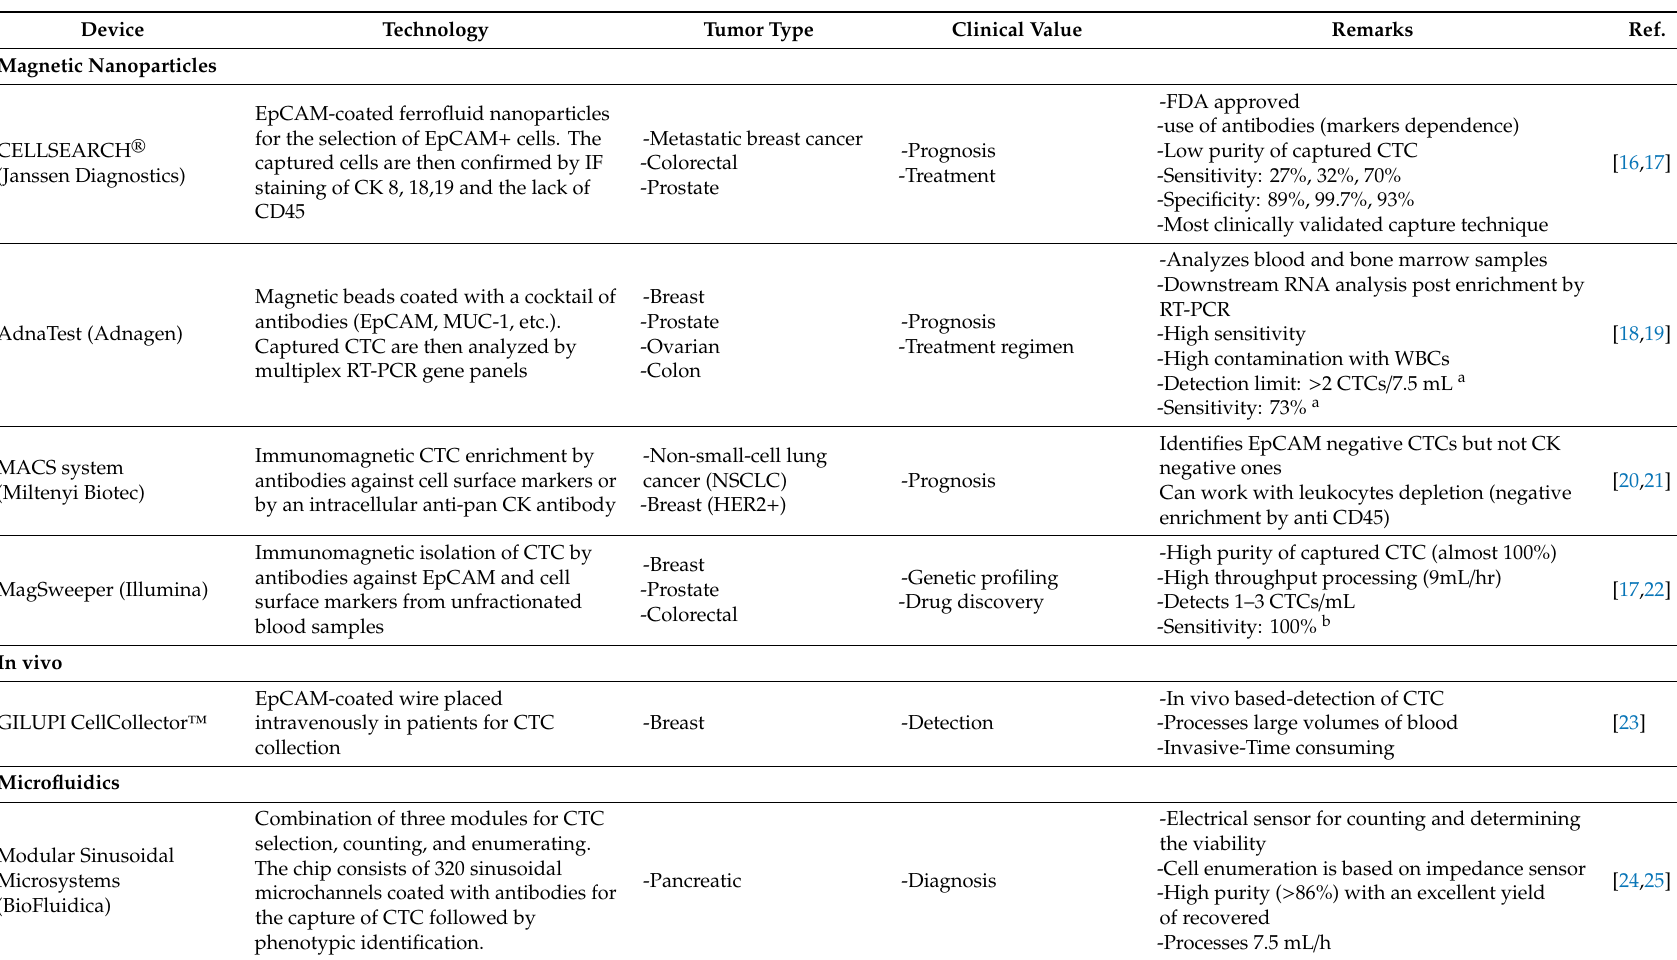
Table 1. Commercially available platforms for CTC detections based on their cell surface markers. (label-dependent